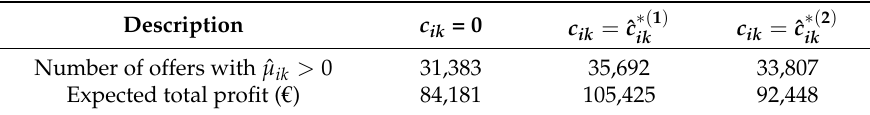
Table 4. Statistics for only the price offers associated with a positive expected profit, ˆ µ ik ( 0 ) >